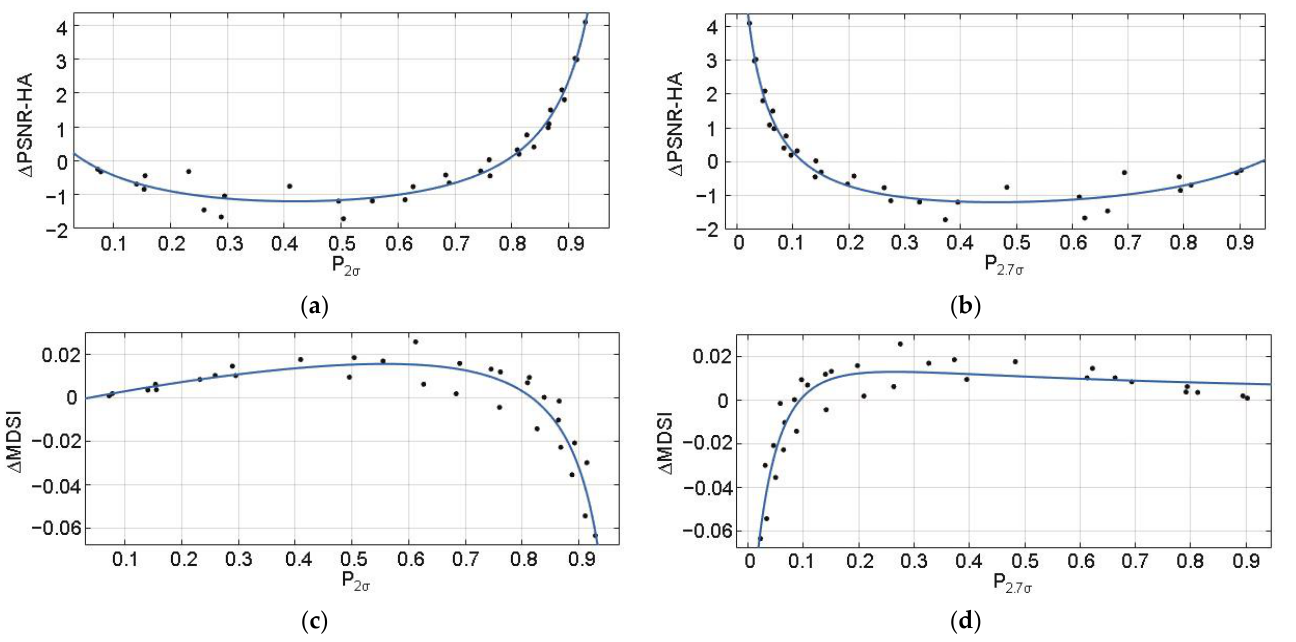
Remote Sens. 2021 , 13 , x FOR PEER REVIEW